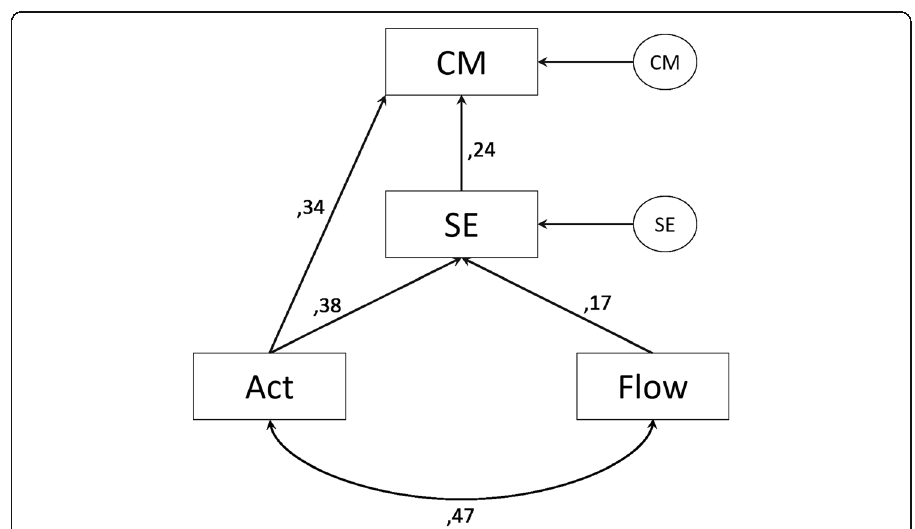
Fig. 4 SEM of Career Motivation through Self-Efficacy and Creativity at measuringtime T1